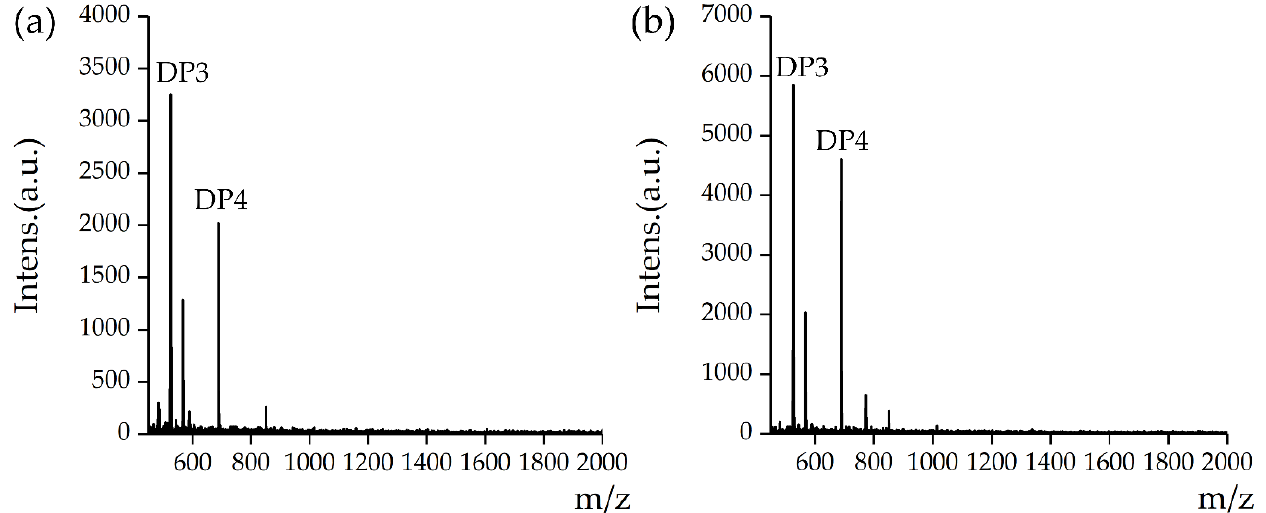
Figure 2. MALDI- TOF mass spectra of β -glucan. ( a ) Water- insoluble β -glucan and ( b ) water- soluble β -glucan. Fragment Figure 2. MALDI-TOF mass spectra of β -glucan. ( a ) Water-insoluble β -glucan and ( b ) water-soluble β -glucan. Fragment DP3 (M w : 526.91); fragment DP4 (M w : 689.16). DP3 (M w : 526.91); fragment DP4 (M w :